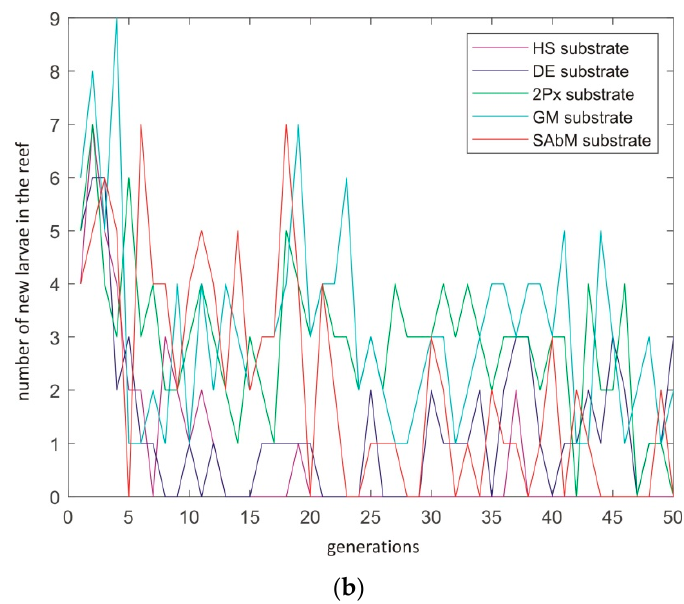
Figure 12. CRO-SL substrate-performance metrics for the two-frequencies antenna optimization; ( a ) Best substrate for larvae generation; ( b ) Best substrate for getting larvae into the reef.